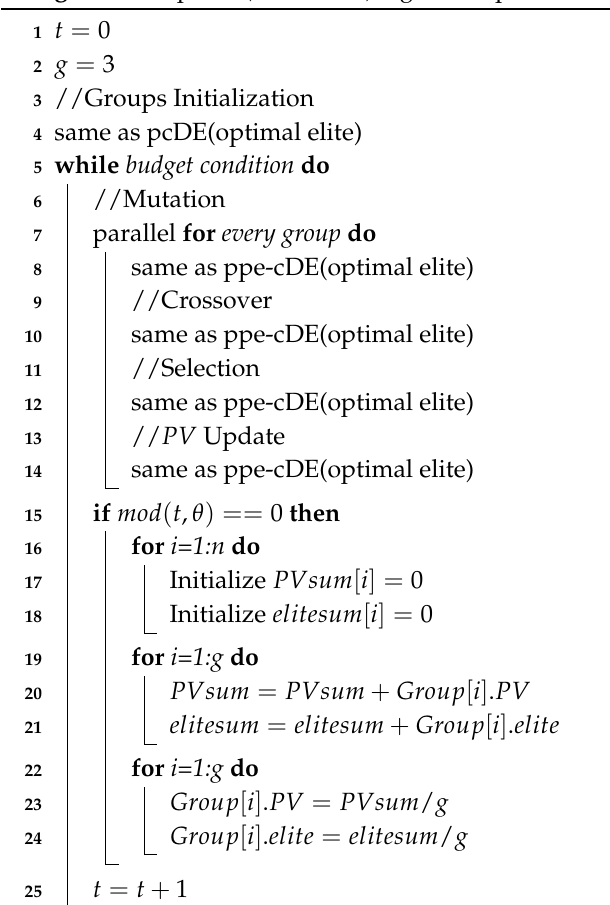
Algorithm 5: pcDE (mean elite) algorithm pseudocode